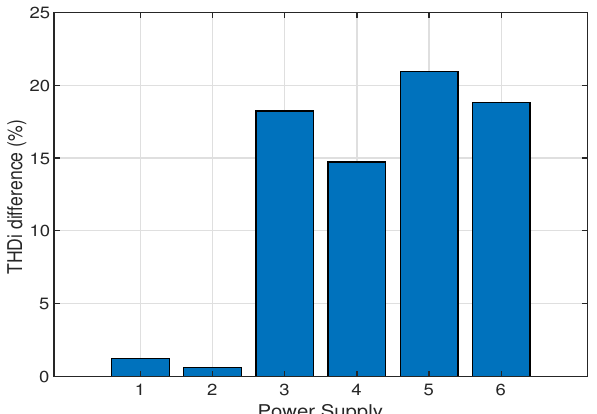
Figure 4. Histogram of total current harmonic distortion (THD i ) difference between cold and stable state of all power